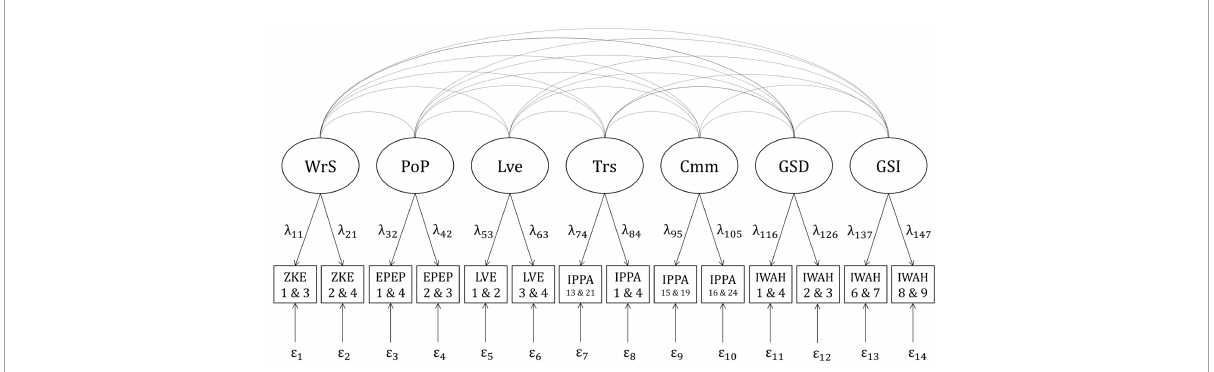
FIGURE1 Positive model with correlations between positive RPB, attachment, and IWAH. WrS, Warmth/Support; PoP, positive parenting; Lve, love; Trs, trust; Cmm, communication; GSD, global self-definition; GSI, global self-investment; ZKE, “Zürcher Kurzfragebogen zum Erziehungsverhalten”; EPEP, “Evaluation des Pratiques Educatives Parentales”; LVE, items measuring parental love; IPPA, “Inventory of Parent and Peer Attachment”; IWAH, “Identification With All Humanity scale”. Latent factors (e.g., WrS) are displayed in circles. Indicators (e.g., ZKE 1 and 3) are displayed in squares. Numbers beneath the abbreviations of questionnaires indicate item numbers of the items forming particular indicators (e.g., Item 1 and item 3 from the ZKE form one indicator displayed as ZKE 1 and 3). Curved lines indicate correlations between latent factors. Arrows with factor loadings (e.g., λ 11 ) illustrate the assumption that the indicators are predicted by specific latent factors. Residual variances are displayed below the indicators (e.g., ε 1